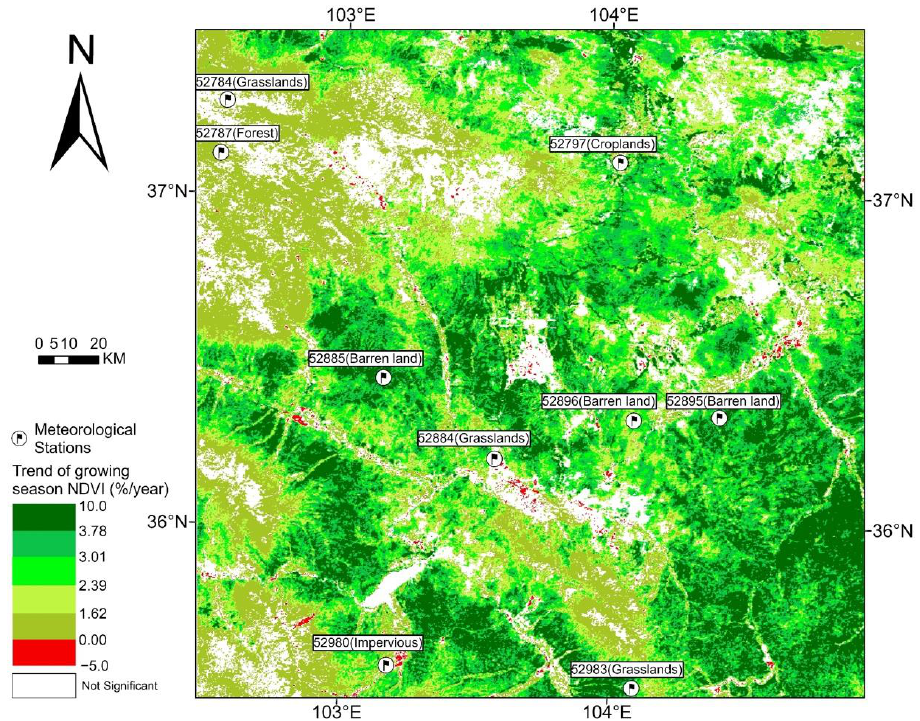
Figure 4. Spatial pattern of the trends of growing season mean NDVI for the study region in the period from 2000 to 2019. The trends were calculated using Sen’s method, and were tested at the 5% level using the Mann–Kendall test. Areas with no statistically significant trends are colored white. The unit of the trends relates to the average growing season NDVI for the years from 2000 to 2002. Remote Sens. 2021 , 13 , 4246